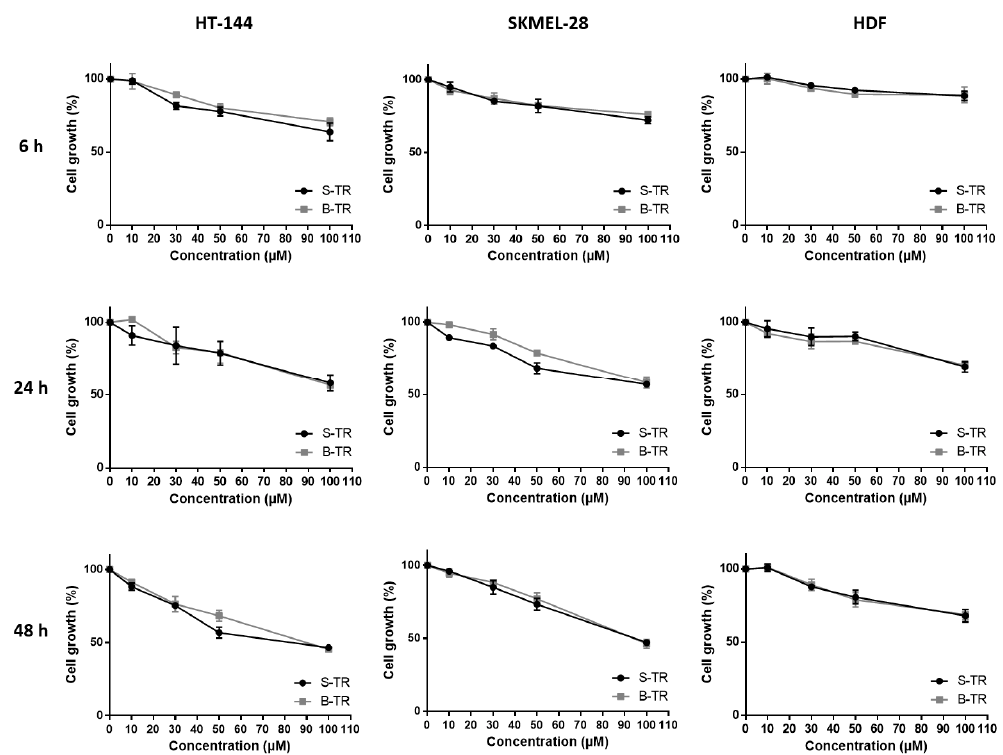
Figure 3. Cell viability inhibition of two different sources of trans -resveratrol. HT-144, SKMEL-28 and HDF cells were treated with various concentrations (10–100 μ M) of synthetic trans -resveratrol (S-TR) and bio-produced trans -resveratrol (B-TR) for 6, 24 and 48 h. Cell viability was determined by the MTT assay. The final volume of ethanol was 0.01% and 0.1% for 10 and 100 μ M concentrations, respectively. Data are expressed as the means ± SD of 3 independent experiments. Each experiment was performed in triplicate